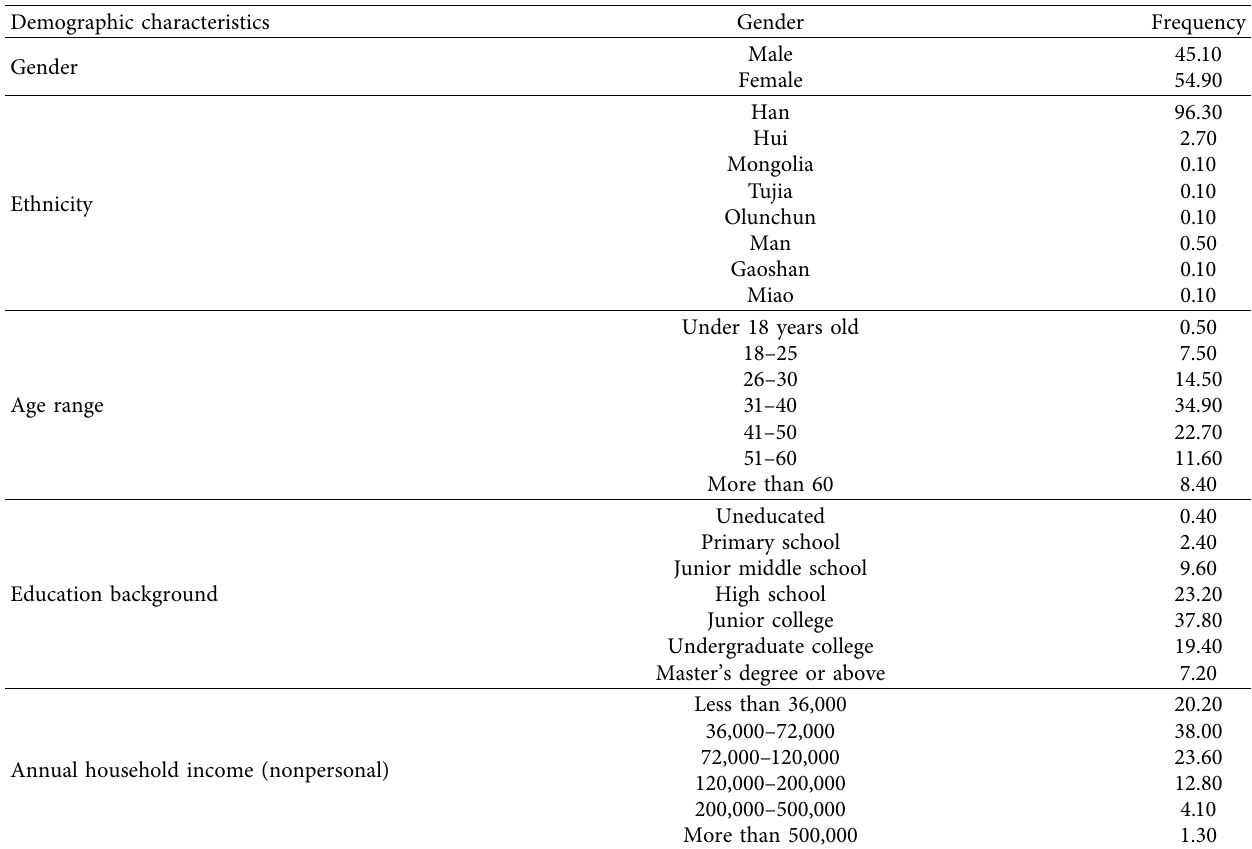
Table 2: Demographic